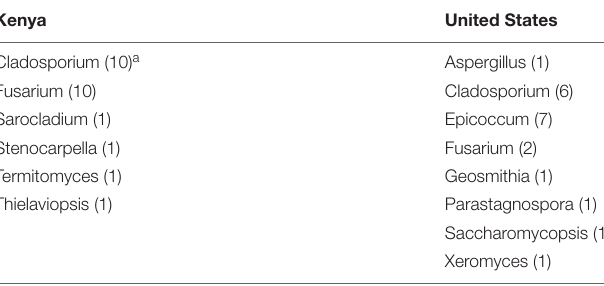
TABLE 5 | Genera identified by BLASTn analysis of the NCBI database with not-assigned category of OTUs.